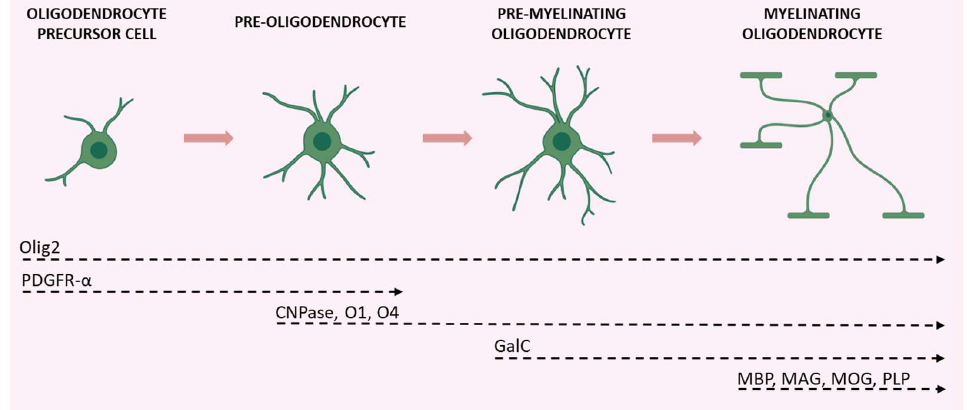
Figure 2. Schematic illustration of the various stages of OPC maturation and corresponding markers. Olig2 is expressed in all stages of the lineage; OPCs and pre-oligodendrocytes are characterized by PDGFR-α expression; CNPase, O1, and O4 are expressed during transition from pre-oligodendrocytes to differentiated oligodendrocytes (which also express GalC); axon-myelinating oligodendrocytes are characterized by myelin protein expression (MBP, MAG, MOG, and PLP). Created with BioRender.com (accessed on 19 August 2022).